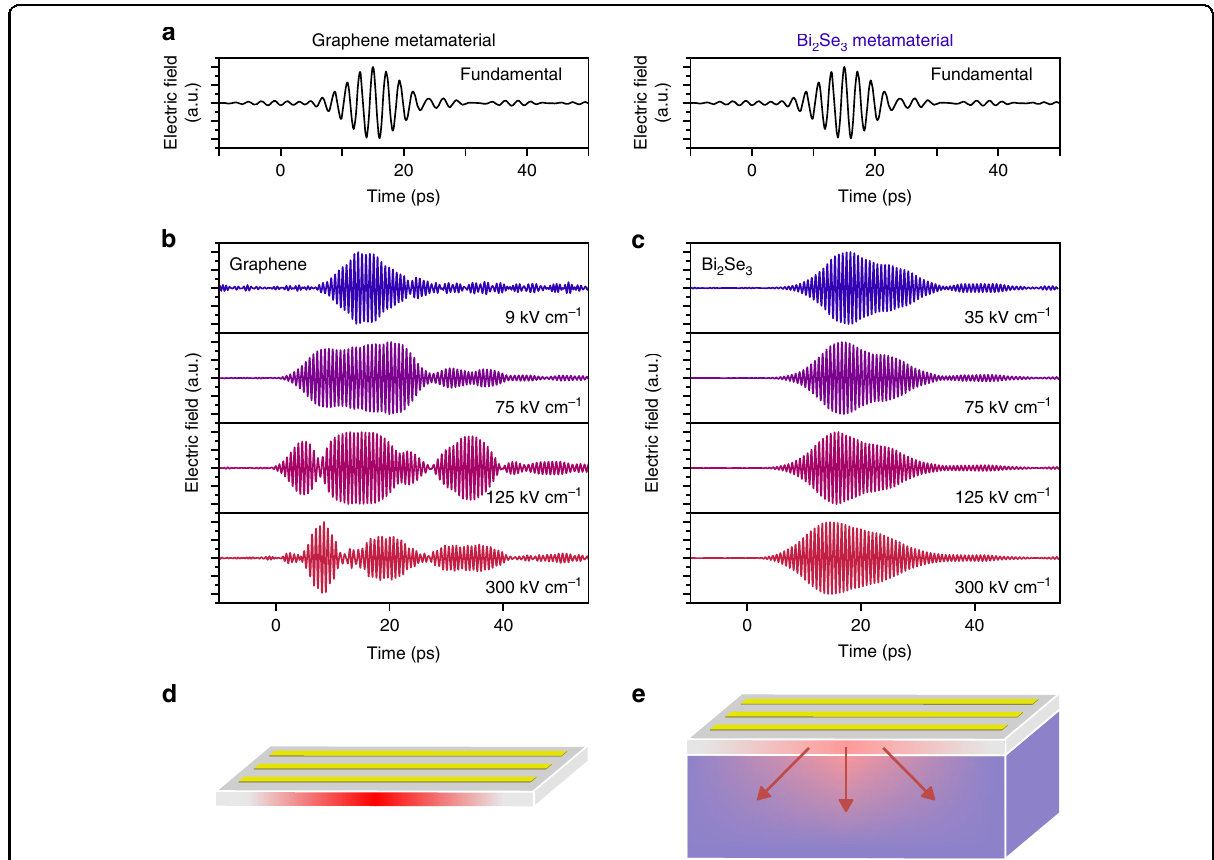
Fig. 2 Time-domain evolution of harmonic generation. a Time-domain dynamics (normalized) of a typical fundamental pulse, as measured through electro-optic sampling. b , c Time-domain dynamics (normalized) of generated third-harmonic signal for graphene ( b ) and Bi 2 Se 3 ( c ), for four different incident peak fi eld strengths. Both samples are measured in the region with a metal grating for fi eld enhancement. Graphene displays complex dynamics because of the interplay between electronic and phononic heat accumulation and heat-induced (near-)complete THz transparency, which leads to saturation of harmonic generation. Due to the ef fi cient surface-to-bulk dissipation of electronic heat in Bi 2 Se 3 , no heat accumulation occurs, and therefore the envelope of the time-domain signal basically follows that of the incident, fundamental waveform. d , e Schematic illustration of heat accumulation in graphene ( d ) and ef fi cient surface-to-bulk dissipation in the TI ( e